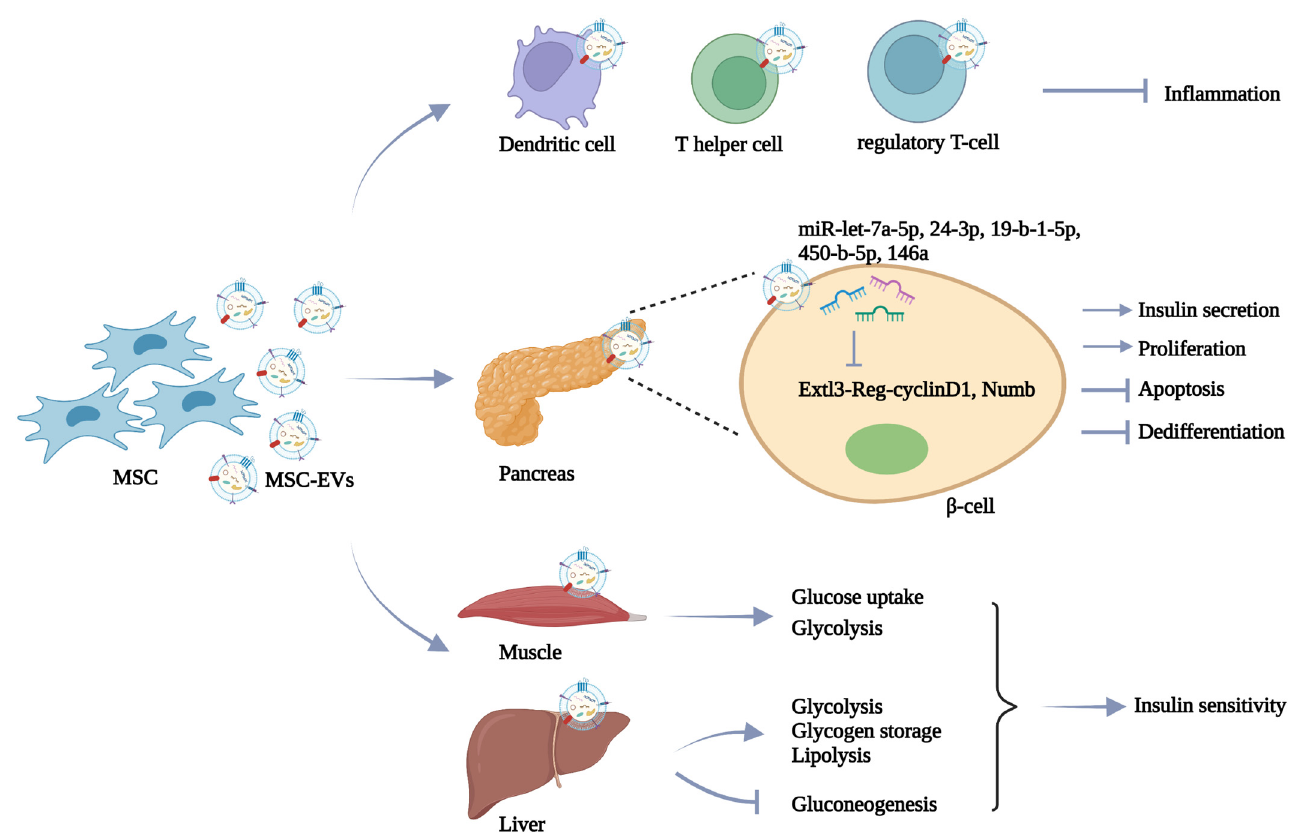
Figure 2. MSC-EVs in DM therapy. MSC-EVs display the ability to alleviate DM progress by regulating immune response, relieving β -cell damage, and reversing peripheral insulin